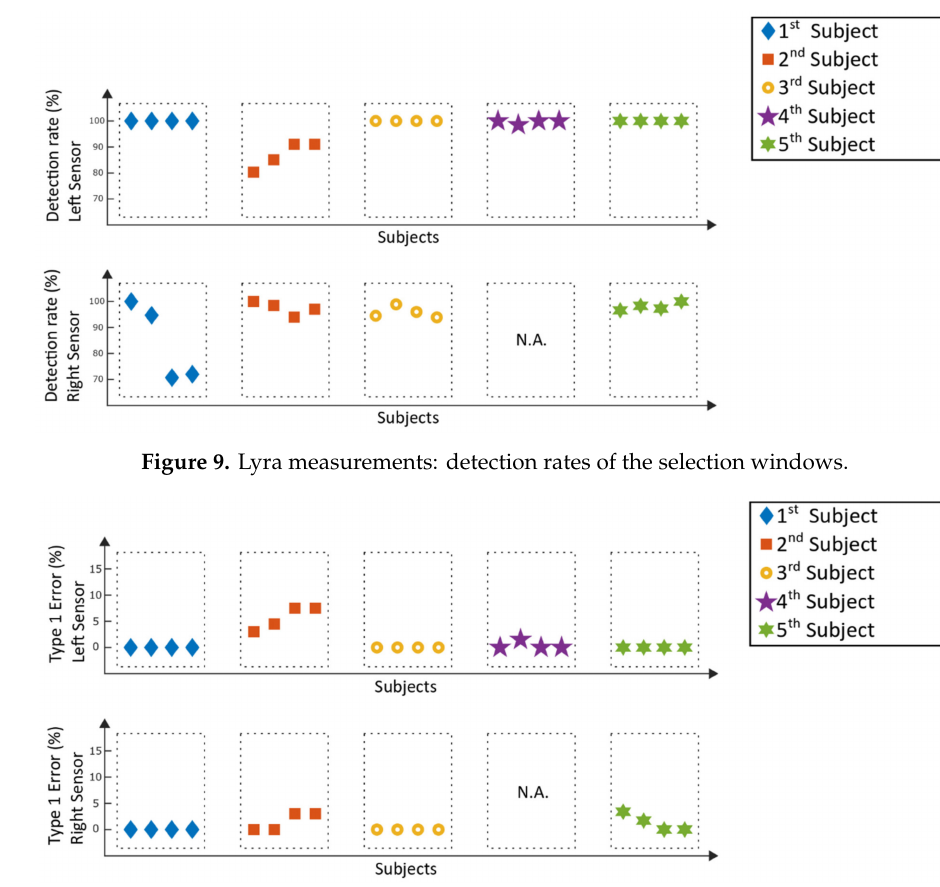
Figure 10. Lyra measurements: type 1 errors of the selection